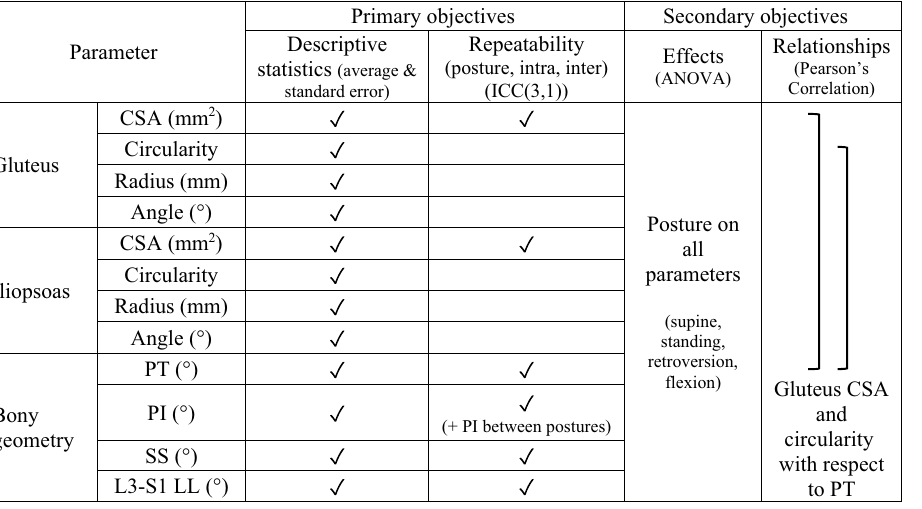
Table 2. Summary of measured parameters and investigated